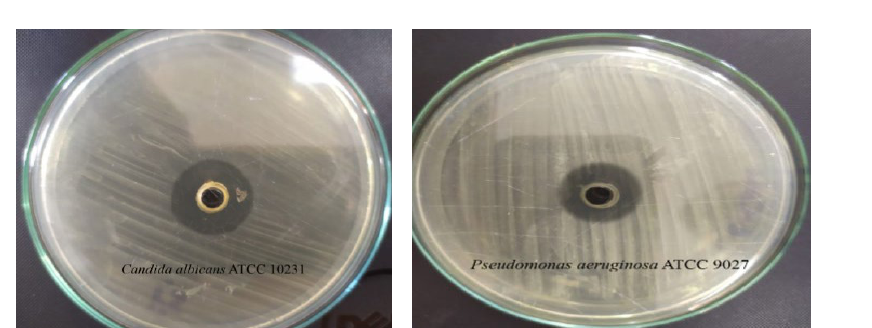
Fig. 8. Illustration of the antimicrobial activity of the EPS production by Halomonas sp. NASH against Candida albicans ATCC 10231 and Pseudomonas aeruginosa ATCC